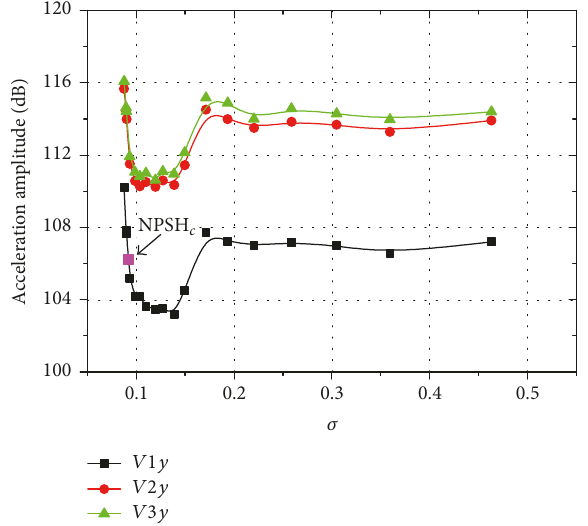
Figure 15: Varying trends of amplitudes at 𝑓 BPF versus cavitation number at nominal flow